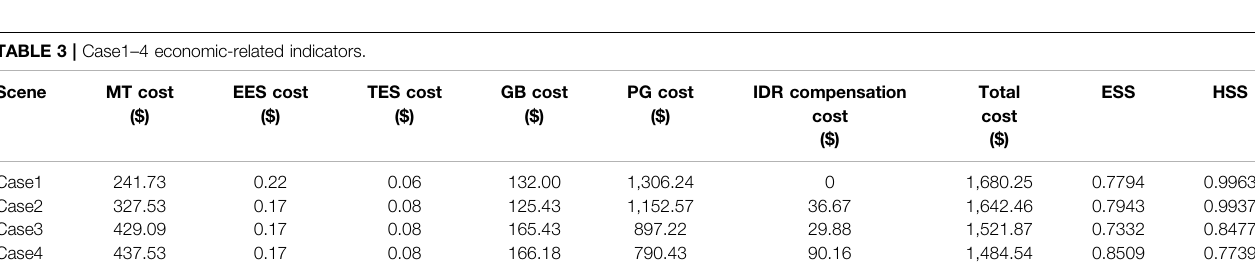
TABLE 3 | Case1 – 4 economic-related